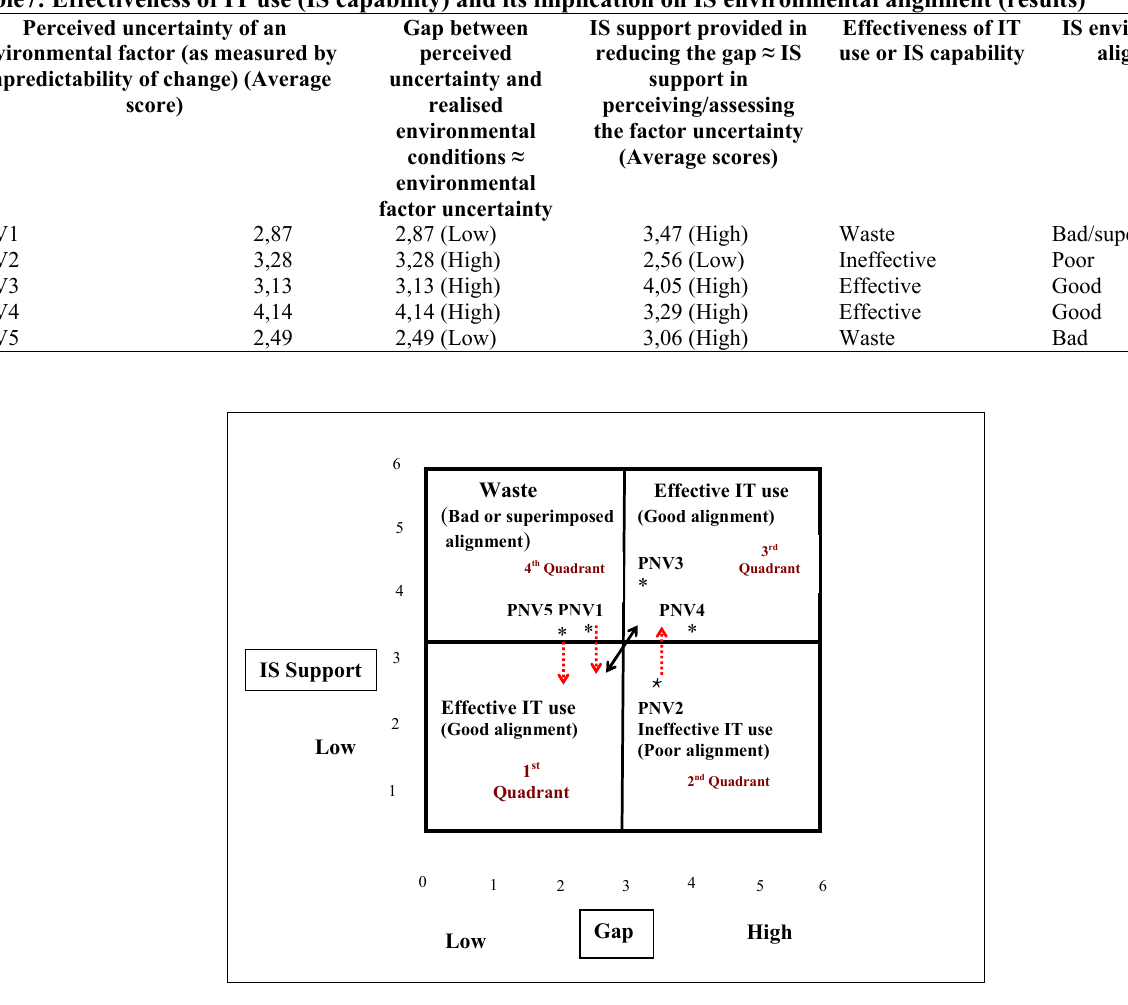
Figure 10: Matrix of alignment showing effectiveness of IT use (IS capability)